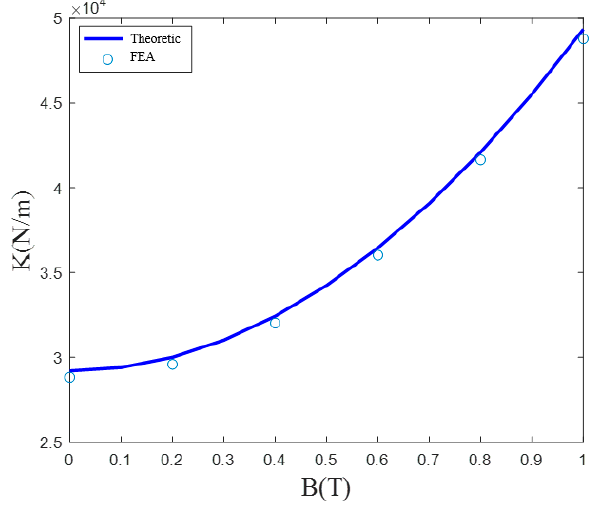
Figure 7. Equivalent stiffness as a function of the applied magnetic field strength.